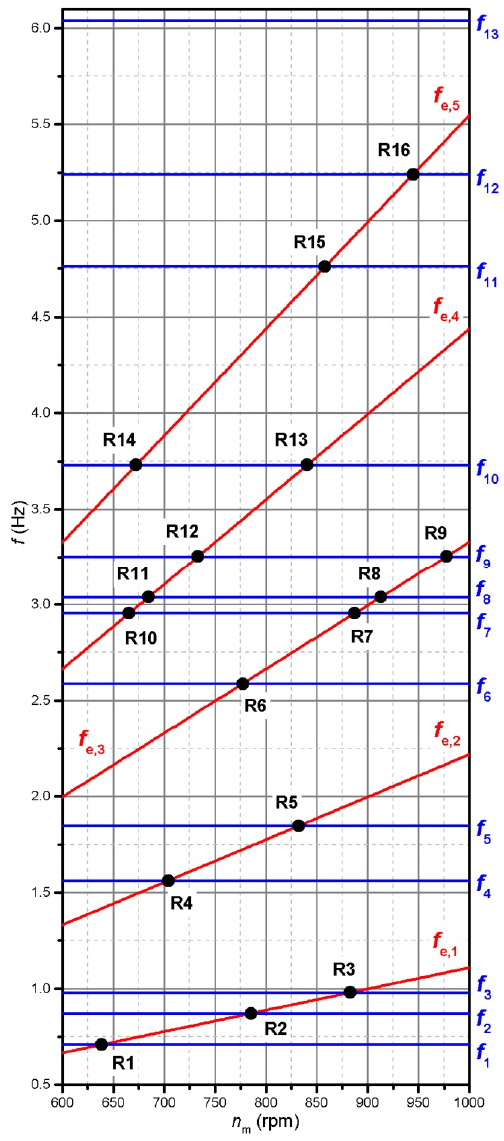
Figure 3. A comparative display of the natural frequencies (blue lines) and frequencies of the first five harmonics of excitation (red lines): Rj, j = 1, 2, 3, …, 16 is the index of the resonant state. five harmonics of excitation (red lines): Rj, j = 1, 2, 3, . . . , 16 is the index of the resonant state. Table 4. Limiting vertical ( a V,per ) and lateral ( a L,per ) accelerations of the referent points. Limiting Accelerations (m/s 2 ) Referent Point Vertical ( a V,per ) Lateral ( a L,per ) BWC, BWD 1.5 0.25 M1T1, M1T2, M2T1, M2T2, CWC 0.4